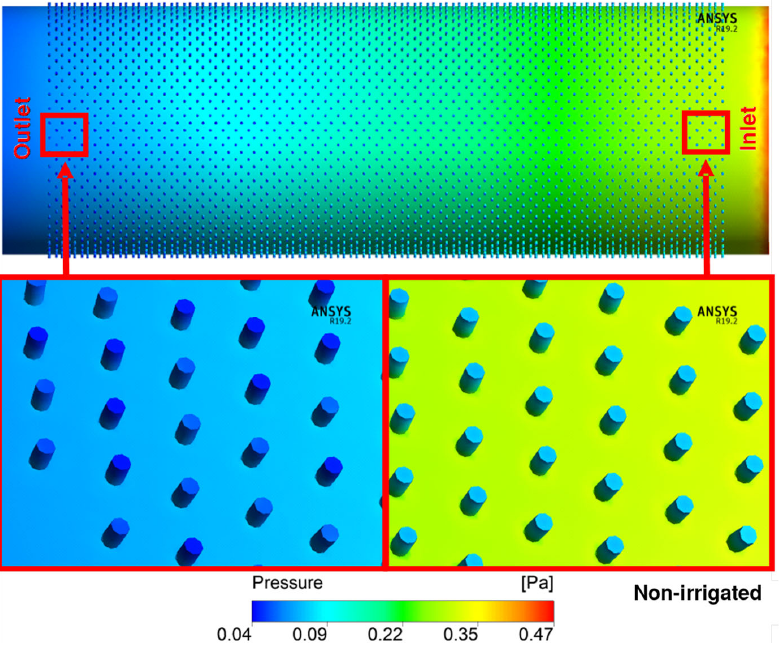
Figure 6. Flow field pressure distribution in section along the axis of non ‐ irrigated vessels.